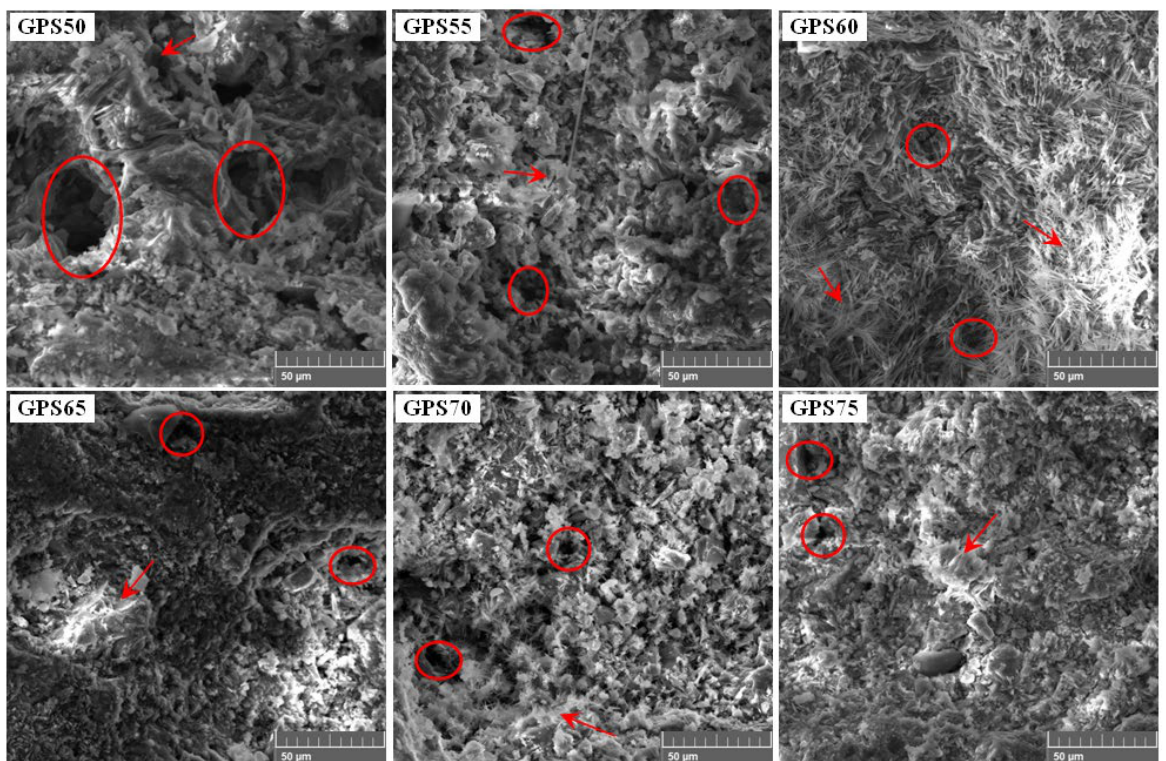
Figure 6. SEM images of GPS50, GPS55, GPS60, GPS65, GPS70, and GPS75 (Circles show porosity, arrows indicate NS agglomerates).